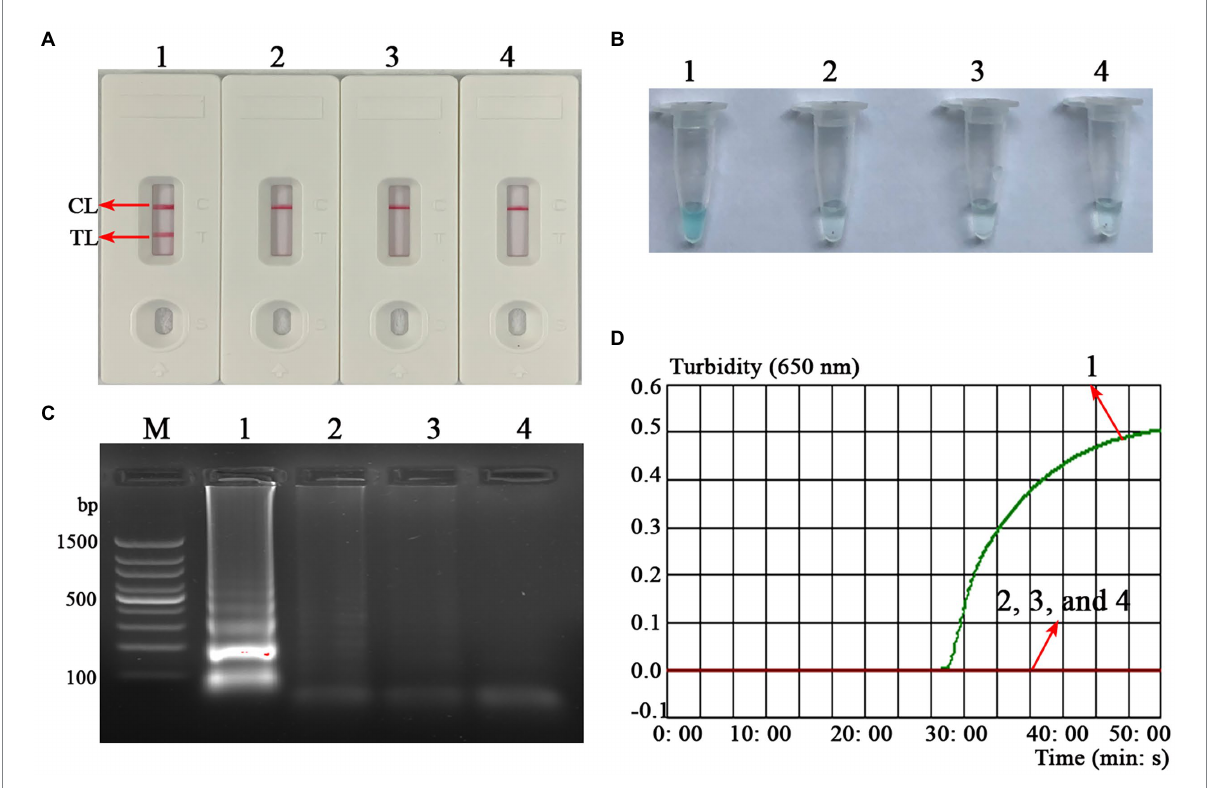
FIGURE 3 Confirmation test of B. abortus -MCDA-LFB assay. To verify the feasibility of the B. abortus -MCDA-LFB assay, the amplification products were reported using AuNPs-LFB biosensor (A) , MG visualization reagents (B) , 1.5% agarose gel electrophoresis (C) , and real-time turbidimetry (D) . Strip ( A1 )/tube ( B1 )/lane ( C1 )/curve ( D1 ): positive reactions of the B. abortus -MCDA-LFB assay; Strip ( A2 )/tube ( B2 )/lane ( C2 )/curve ( D2 ): negative control ( Mycobacterium tuberculosis ) of the B. abortus -MCDA-LFB assay; Strip ( A3 )/tube ( B3 )/lane ( C3 )/curve ( D3 ): negative control (environmental sample in the test) of the B. abortus -MCDA-LFB assay; Strip ( A4 )/tube ( B4 )/lane ( C4 )/curve ( D4 ): blank control (nuclease-free water) of the B. abortus -MCDA-LFB assay. Line M , 100 bp DNA ladder; MCDA, multiple cross displacement amplification; AuNPs-LFB, gold nanoparticles-based lateral flow biosensor; TL, test line; CL, control